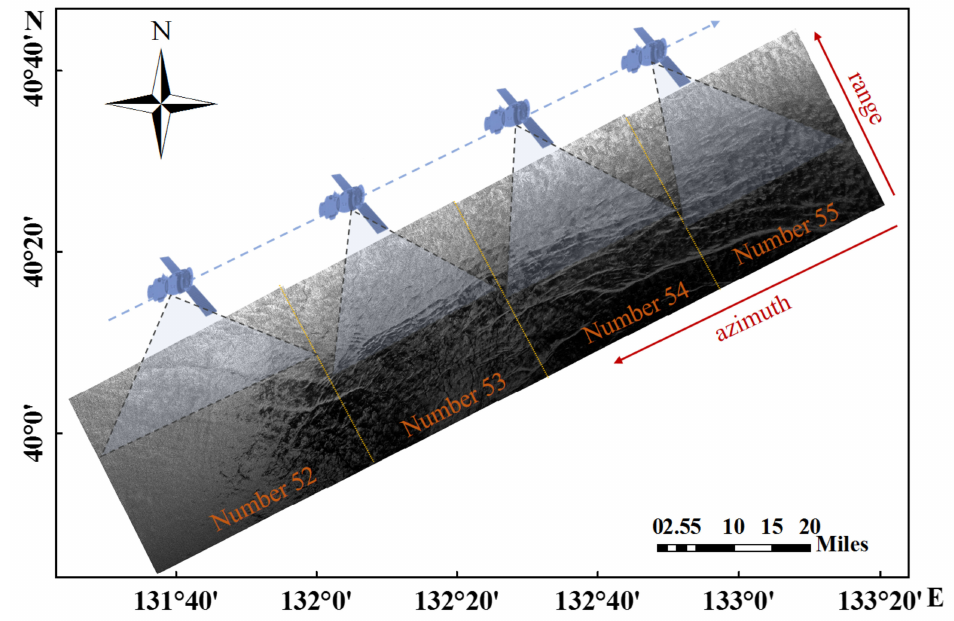
Figure 9. The resulting image of the stitching of the images in Figure 7. The image data numbers are 52–55, and the blue dashed line represents the flight direction of Tiangong-2.